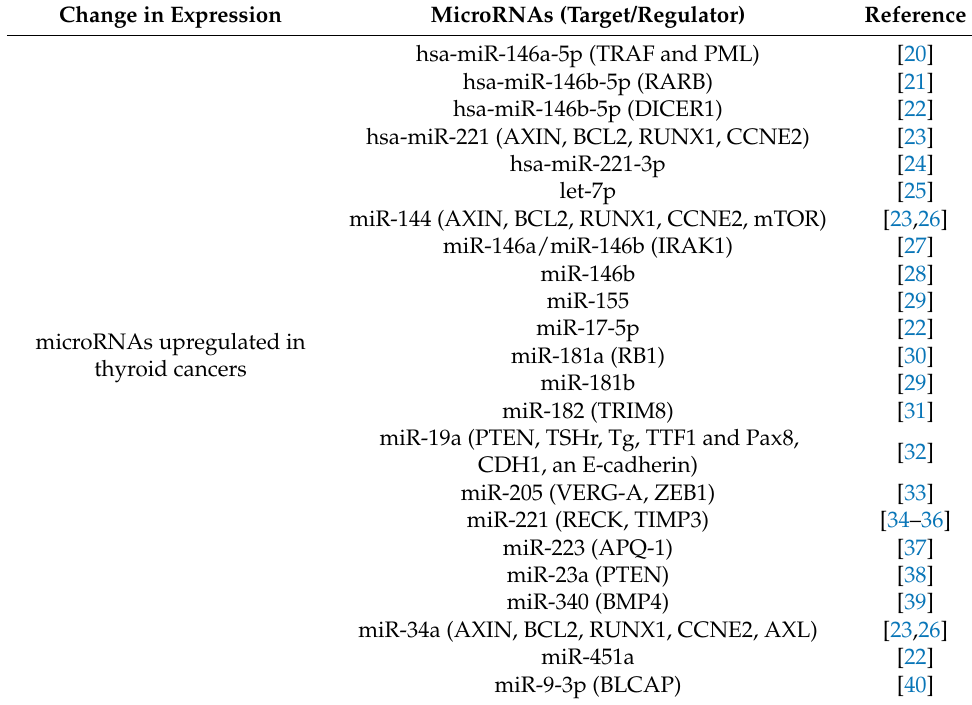
Table 1. List of microRNAs associated with thyroid cancer.